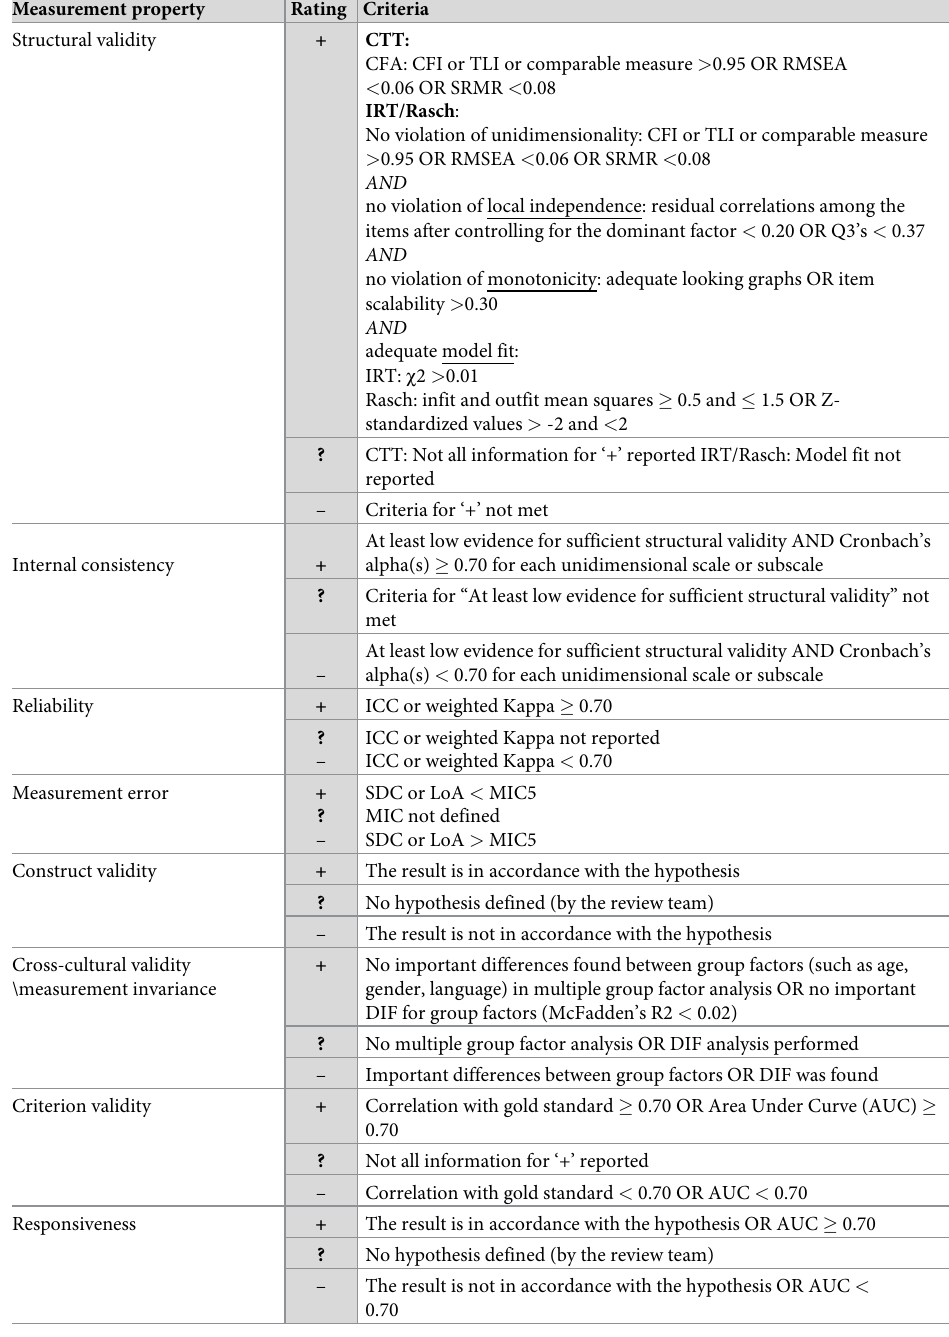
Table 4. Updated COSMIN criteria for good measurement